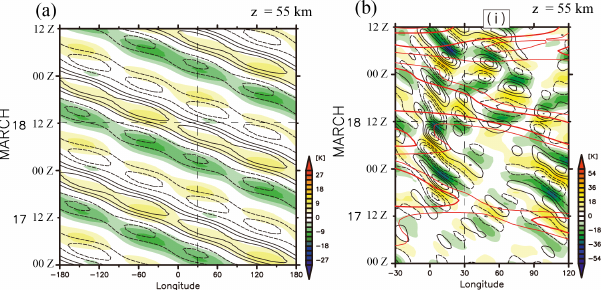
Figure 18. (a) A Hovmöller diagram of potential temperature (shade) and the vertical wind components (contour) due to the diur- nal and semidiurnal migrating tides at the height of 55km at 65 ◦ S. The contour interval is 0.5 × 10 − 2 ms − 1 . (b) A Hovmöller diagram of potential temperature (shade) and the vertical wind components (black contour) of the large-scale inertia gravity waves, and the zonal wind component with s = 1 and s = 2 at the height of 55km at 65 ◦ S. The black contour interval is 2.0 × 10 − 2 ms − 1 , the red thin contour denotes 30ms − 1 and the red thick contour denotes 35ms − 1 . The data are from the NICAM